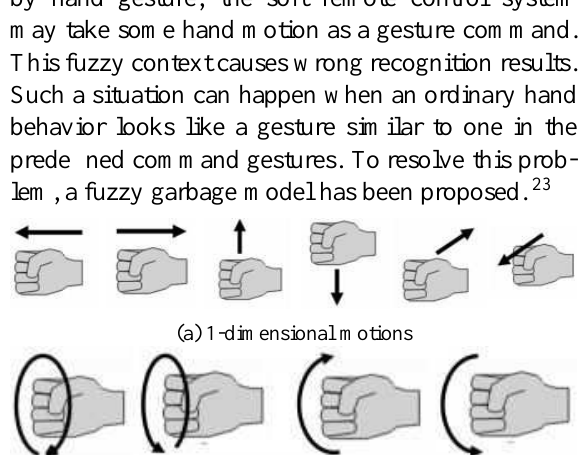
Fig. 6. Soft remote control system in the Intelligent Sweet Home